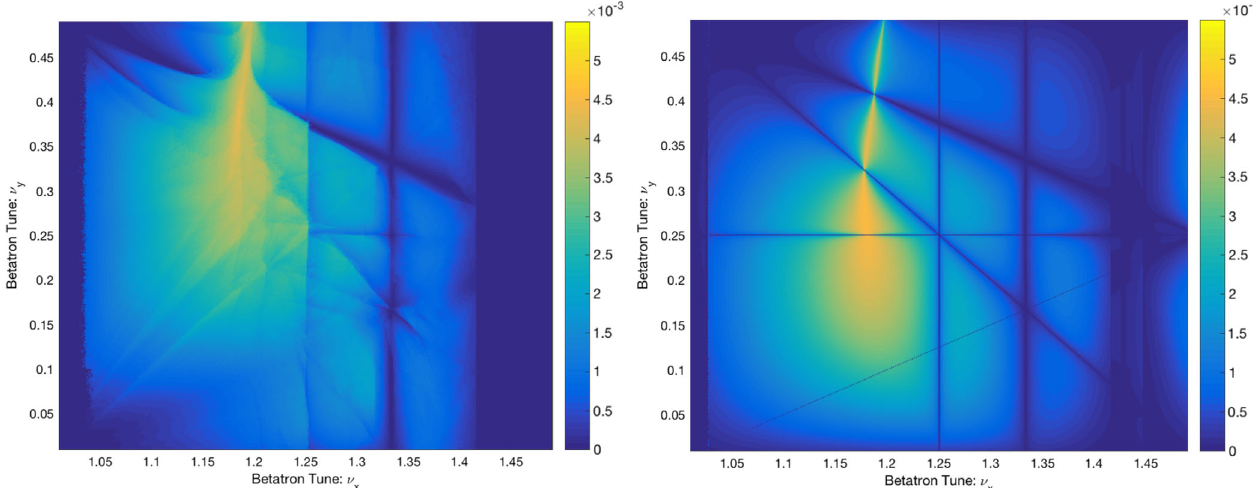
FIG. 10. Comparison of the dynamic aperture in the normalized coordinates in tracking (left) and a statistical model based on the third- and fourth-order resonances driving terms in the effective Hamiltonian (right).